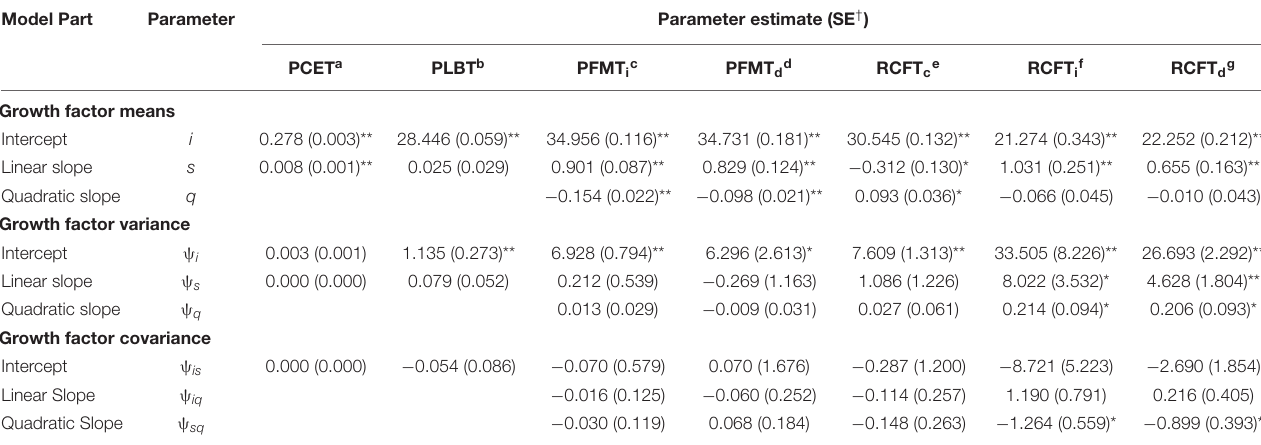
TABLE 4 | Intercept and slope factor parameter estimates for unconditional